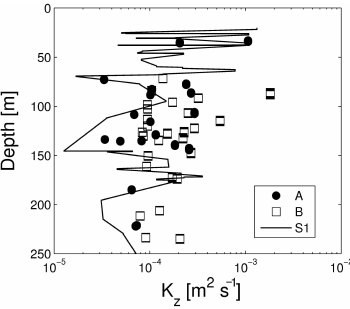
Figure 5. Comparisons of vertical turbulent diffusivities ( K z ) be- tween two stations A and B. Black line is the result of the reference station S 1 with continuous CTD sampling up to 13 casts; circles are for station A (2 casts) with squares for station B (2 casts).